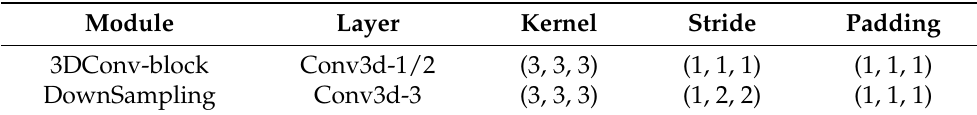
Figure 3. MSSTNet network structure. The input sequence frames are sent into ( a ) shallow distribu- tion feature extraction module for shallow feature extraction. After shallow feature extraction, the features will enter ( b ) deep motion feature extraction module for spatial-temporal motion feature extraction. Finally, deep motion feature and shallow distribution feature are sent to ( c ) decoding network module to generate predicted sequence frames Table 1. Architecture of 3D convolution in module